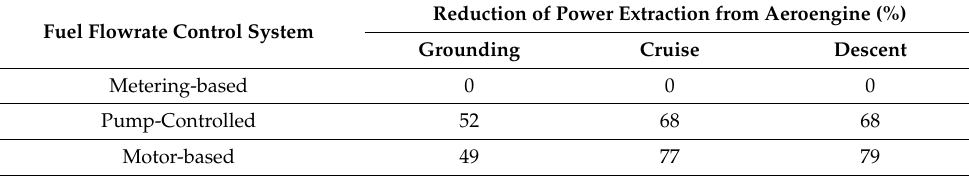
Table 3. Comparison of aeroengine power reduction under different flight mission conditions.